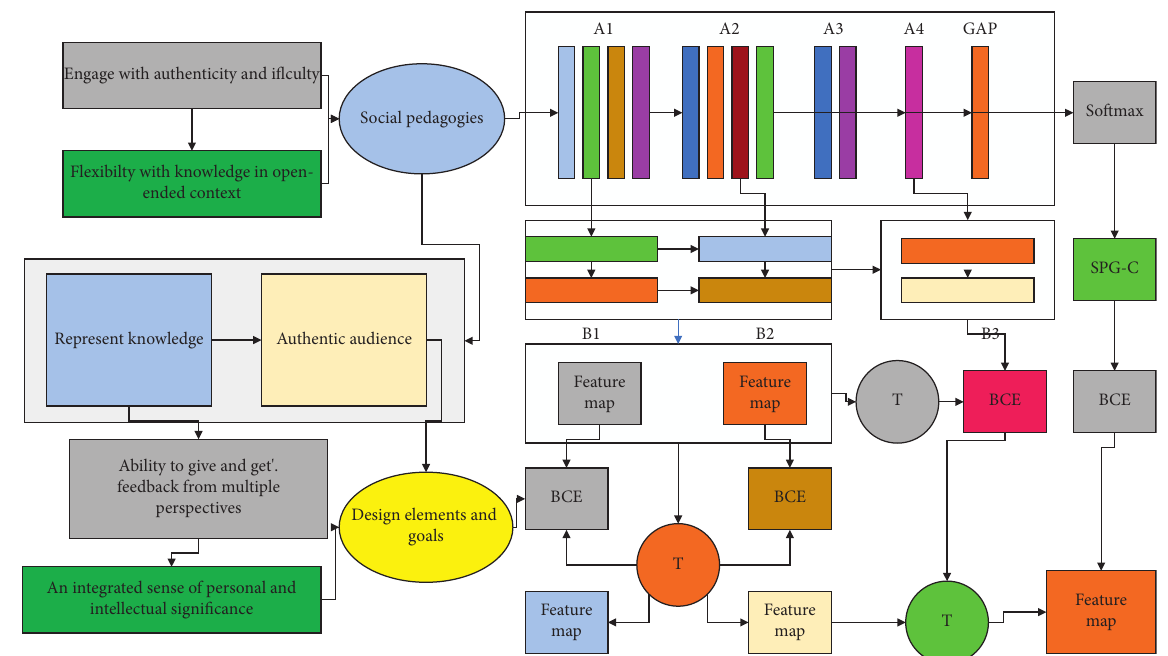
Figure 3: Overall system